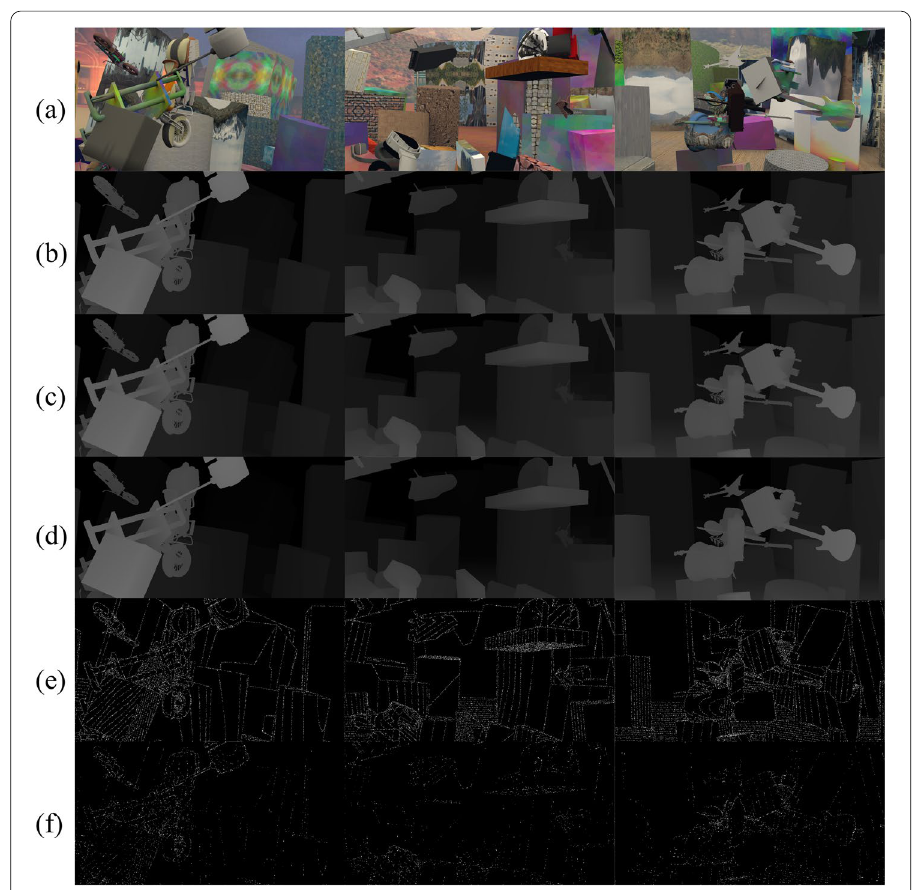
Fig. 10 Visualization results on Flyingthings3D sub‑dataset: a color map, b ground‑truth depth, c depth map with errors, d refined depth map, e error map before refinement, f error map after